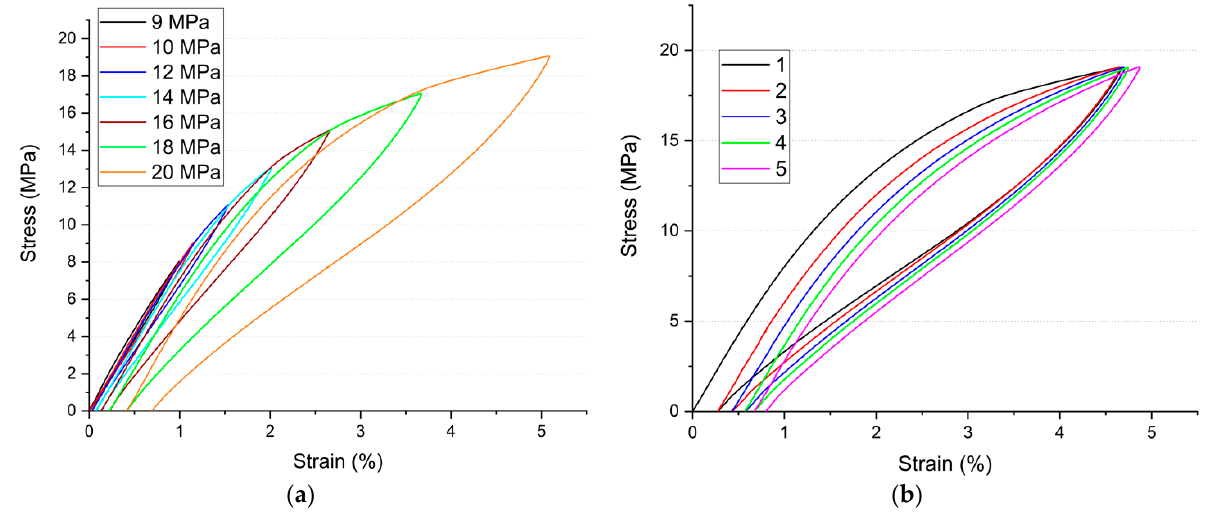
Figure 12. Sample cycling by compression loading: ( a ) Cycling with stress rising from 9 to 20 MPa; ( b ) five cycles under 20 MPa.